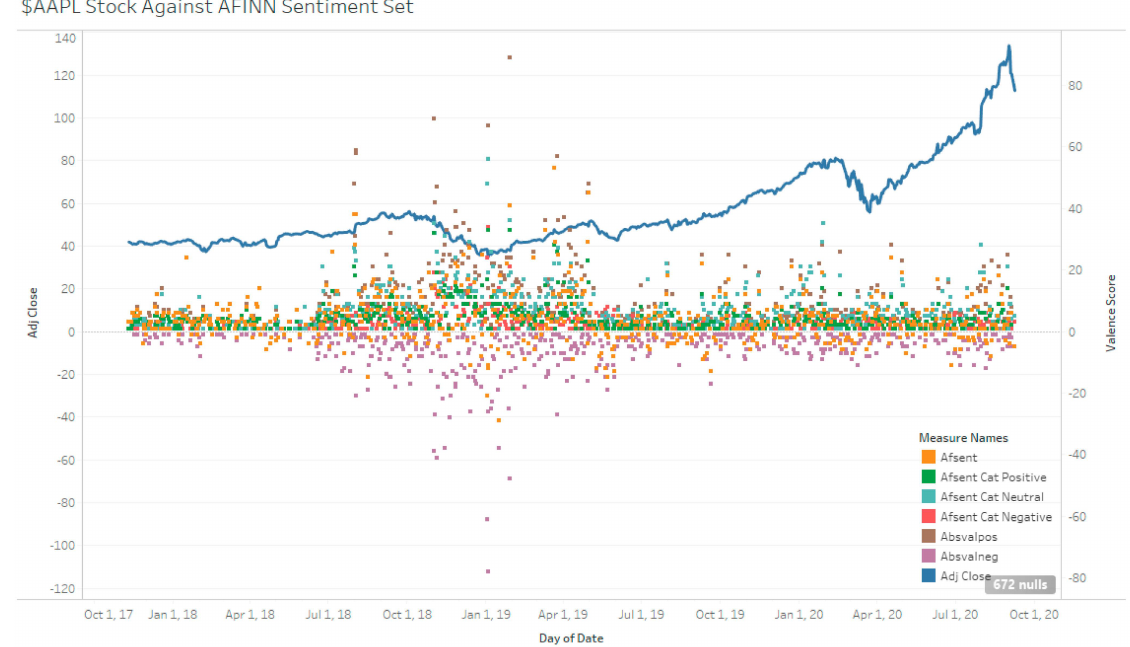
Figure 8. AAPL Stock Against AFINN Sentiment.